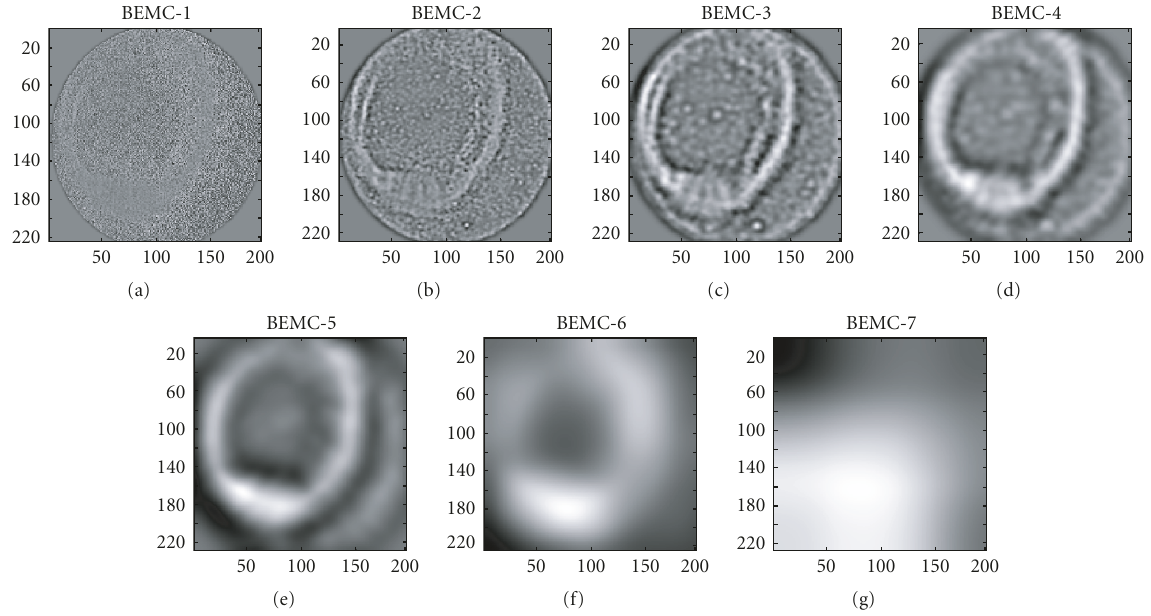
Figure 23: BEMCs of noisy aurora image obtained by FABEMD with Type-1 OSFW (MNAI =